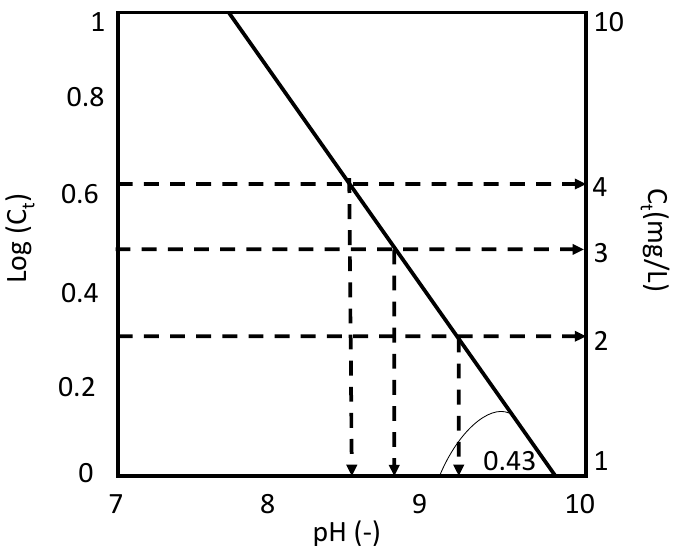
Figure 7. Logarithm of residual phosphorus concentration in sequential batch polishing ponds as a function of the